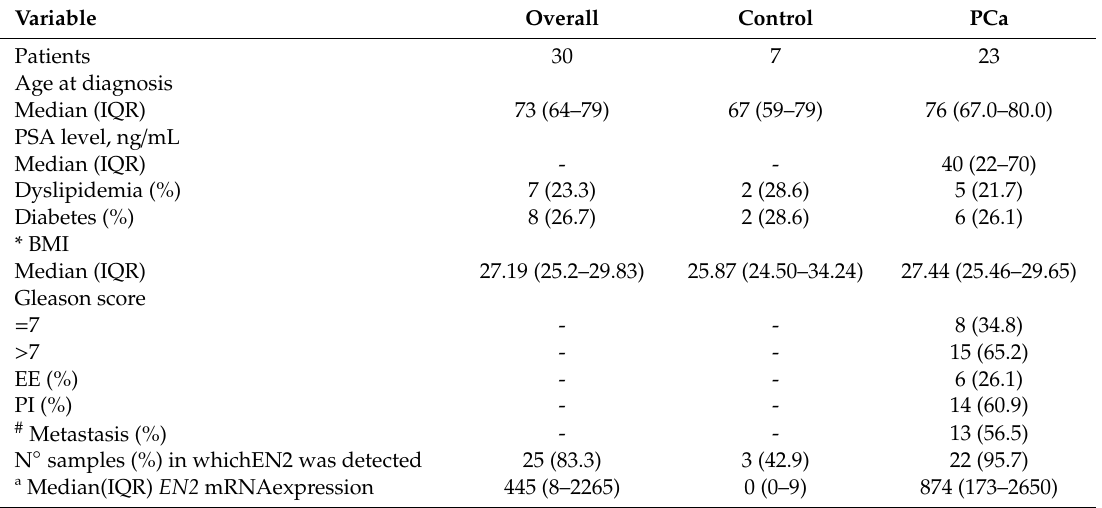
Table 2. Overall clinical and demographic data of fresh samples from patients with normal prostates and PCa samples.